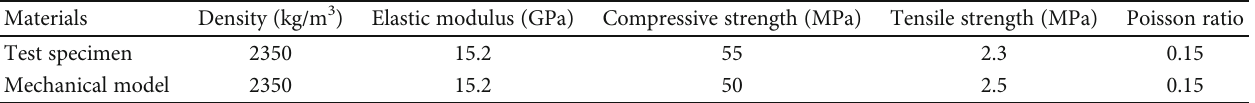
Table 7: Mechanical parameters from test and numerical